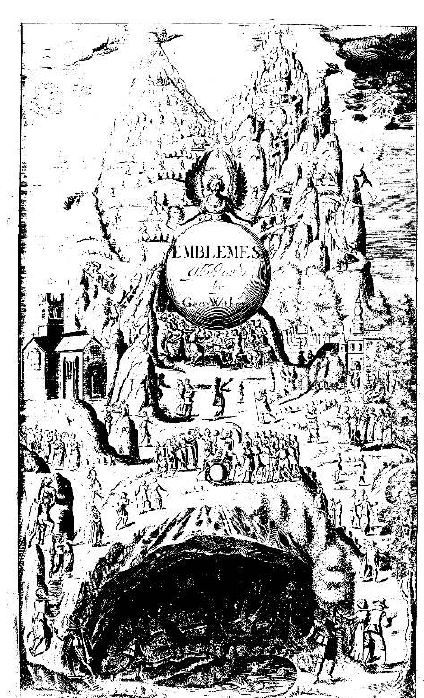
Source: The British Library; STC